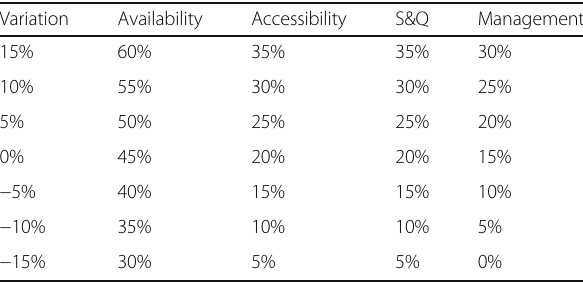
Table 6 Weights used in the sensitivity analysis